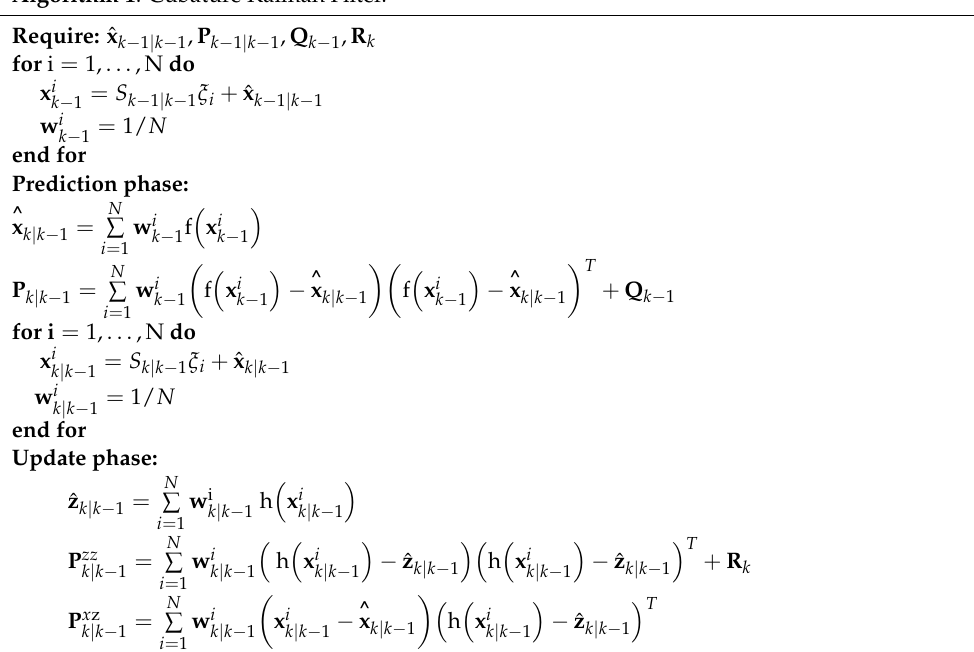
Algorithm 1 : Cubature Kalman